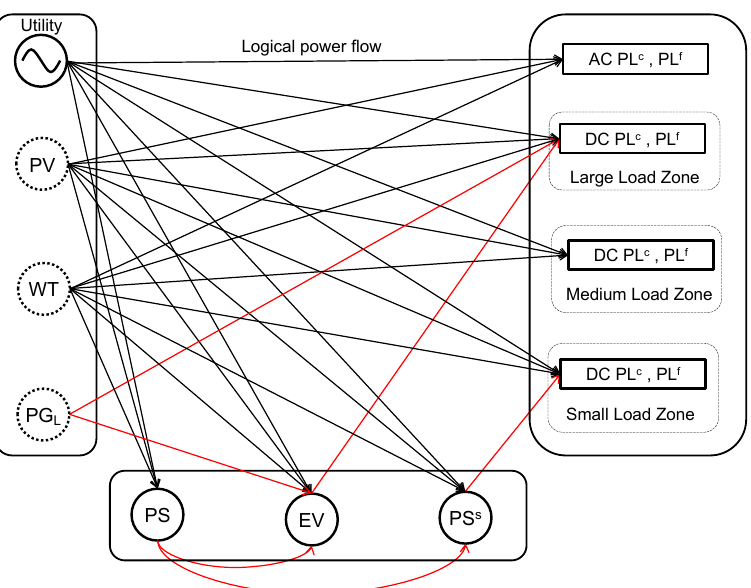
Figure 1. Example of a power flow system with power generators, power loads, power storage devices, and physical connections between power devices through electrical buses.